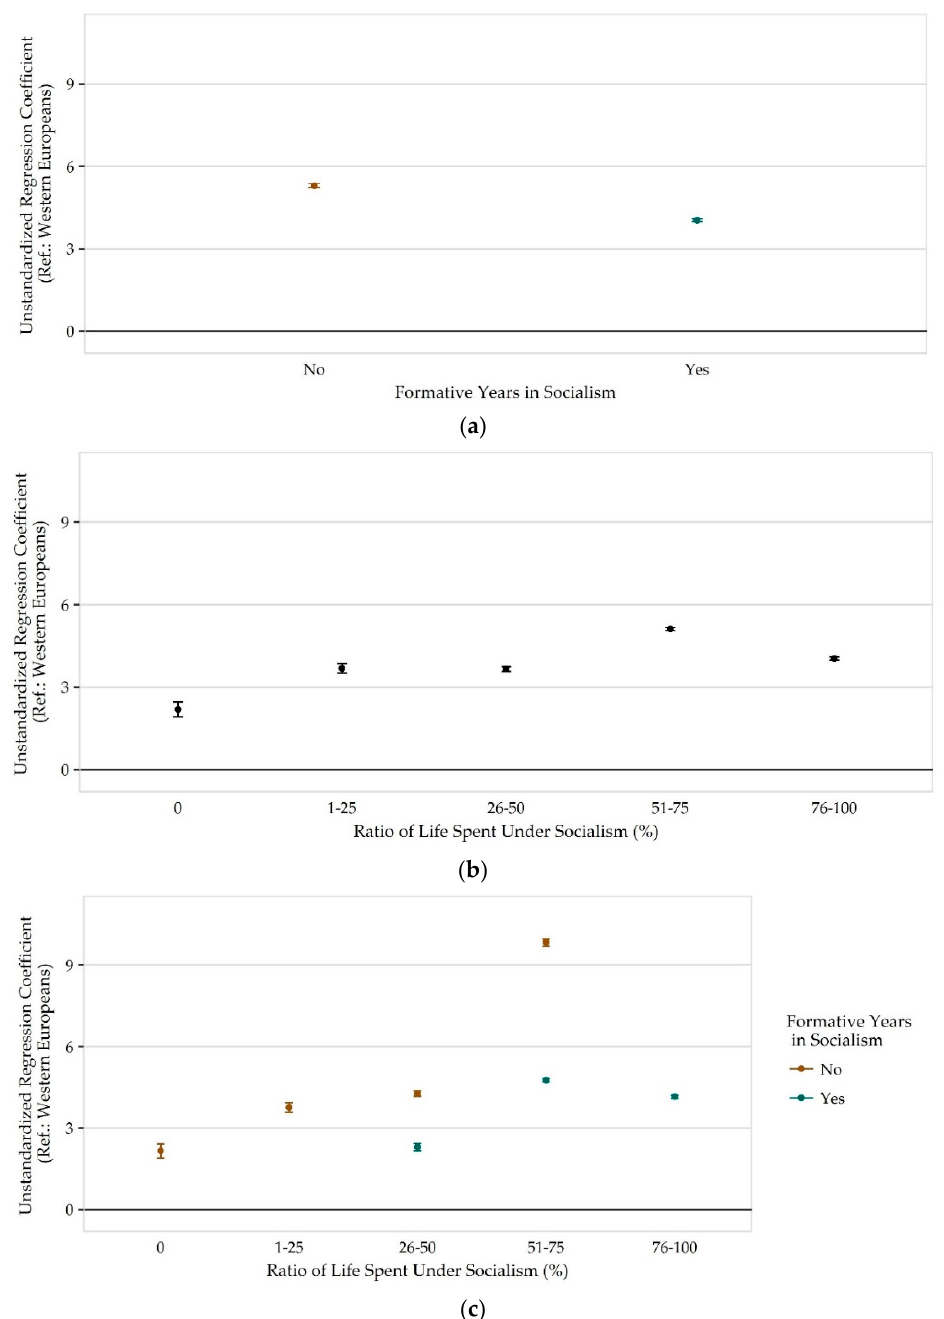
Figure 4. Value of (unstandardized) regression coefficients of “Post-socialist” country dummy for explaining preferred subjective Gini: ( a ) Respondents divided by their formative year; ( b ) Respondents divided by their exposure rate; ( c ) Respondents divided by their formative years and their exposure rate. Notes : ISSP, own calculations. Marginal effects with 95% confidence interval from bootstrapped OLS regressions. For corresponding models and analysis see Tables A7–A9 in Appendix D.